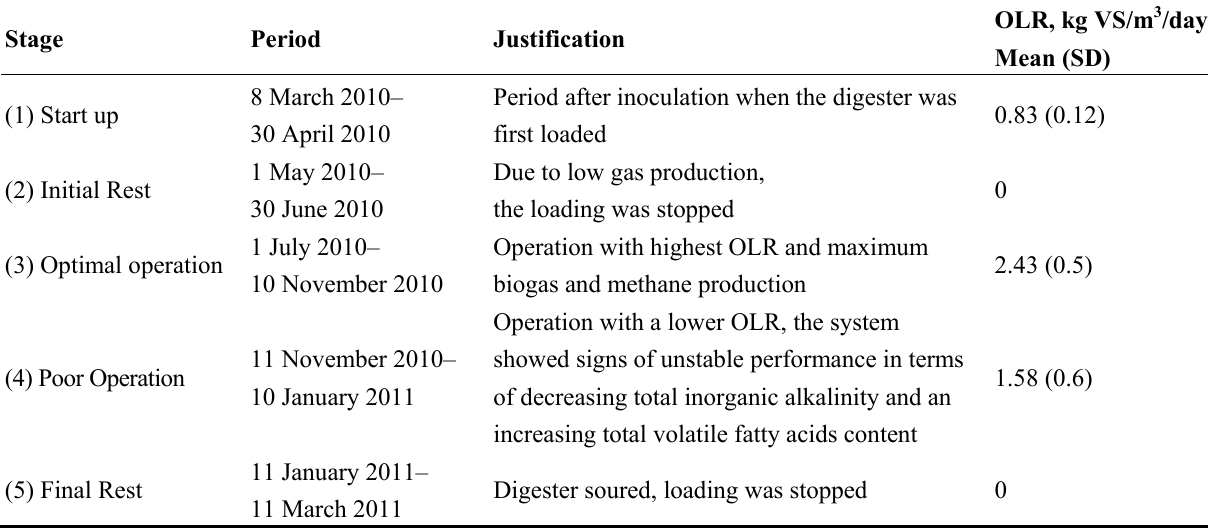
Table 2. Digester operational stages. Operational data were split into five stages according the organic loading rate used and digester